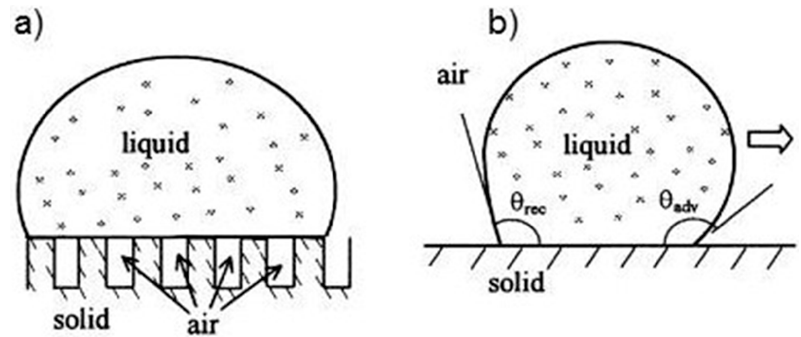
Figure 1. ( a ) Droplet over a patterned heterogenous surface; ( b ) definition of advancing ( θ adv ) and receding ( θ rec ) contact angles for a moving droplet on an inclined surface (hysteresis) [30].